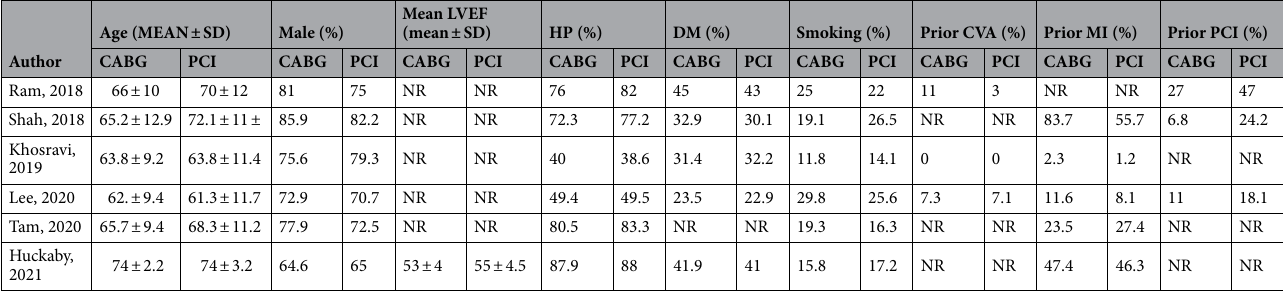
Table 4. Demographic data from the included studies (part 3). CABG coronary arterial bypass graft, CVA cerebrovascular accident, DM diabetes, HP hypertension, LVEF left ventricular ejection fraction, MI